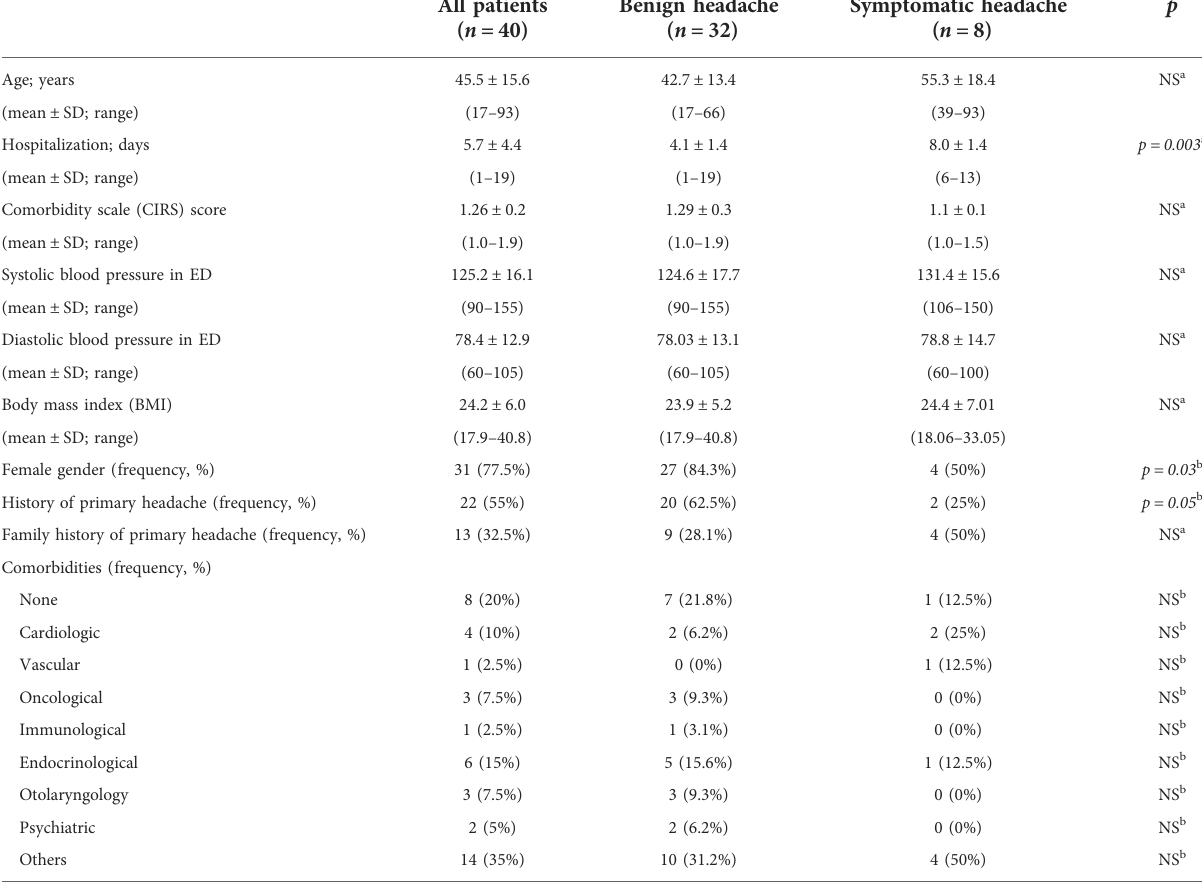
TABLE 1 Demographical and clinical characteristics of all hospitalized